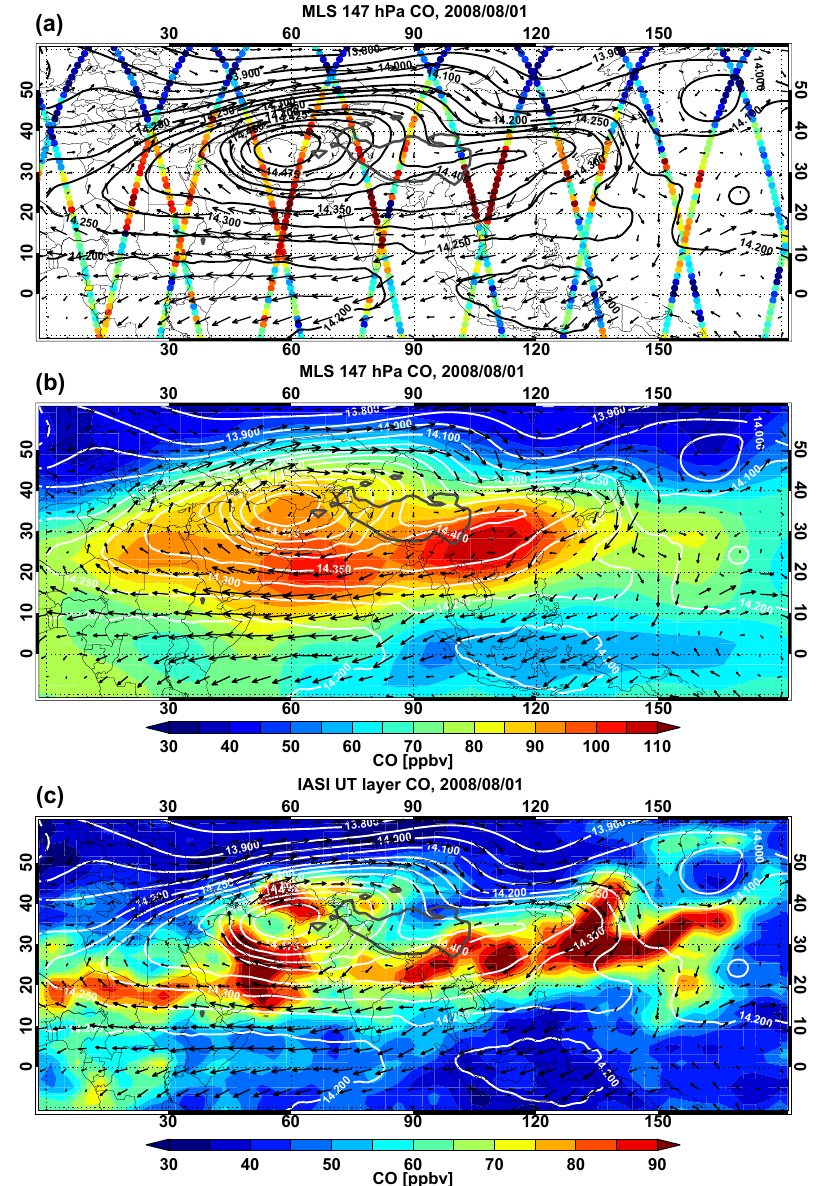
Figure 2. (a) MLS 147hPaCO mixing ratio at retrieval geolocations on 1 August 2008, (b) the interpolated map of MLS CO, and (c) the interpolated map of IASI CO in the upper troposphere (UT) layer on 1 August 2008. The selected geopotential height (GPH) contours (white) and horizontal winds (black arrows) at 150hPa are superimposed. The MLS CO map is made with 5 ◦ × 5 ◦ longitude and latitude grids. The IASI CO map is made using 3 ◦ × 2 ◦ grids. Both are interpolated using the natural neighbor algorithm (Watson,